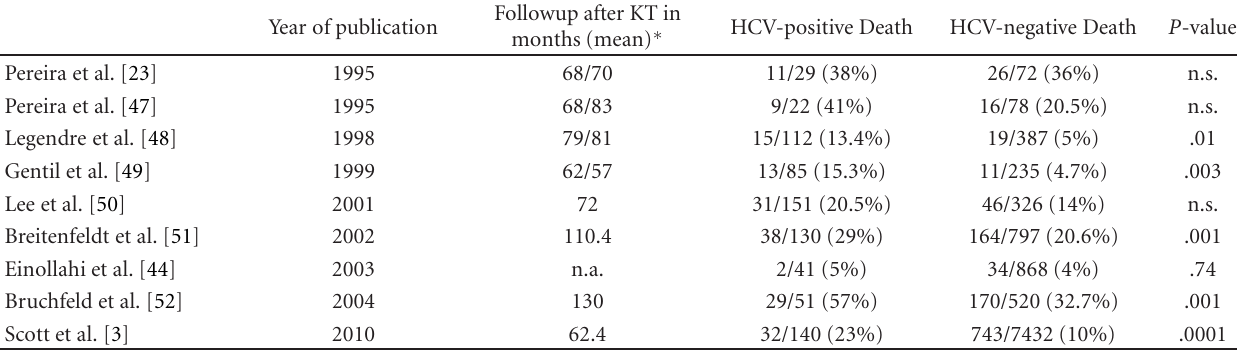
Table 2: Death rate in HCV+ve versus HCV − ve patients after Kidney